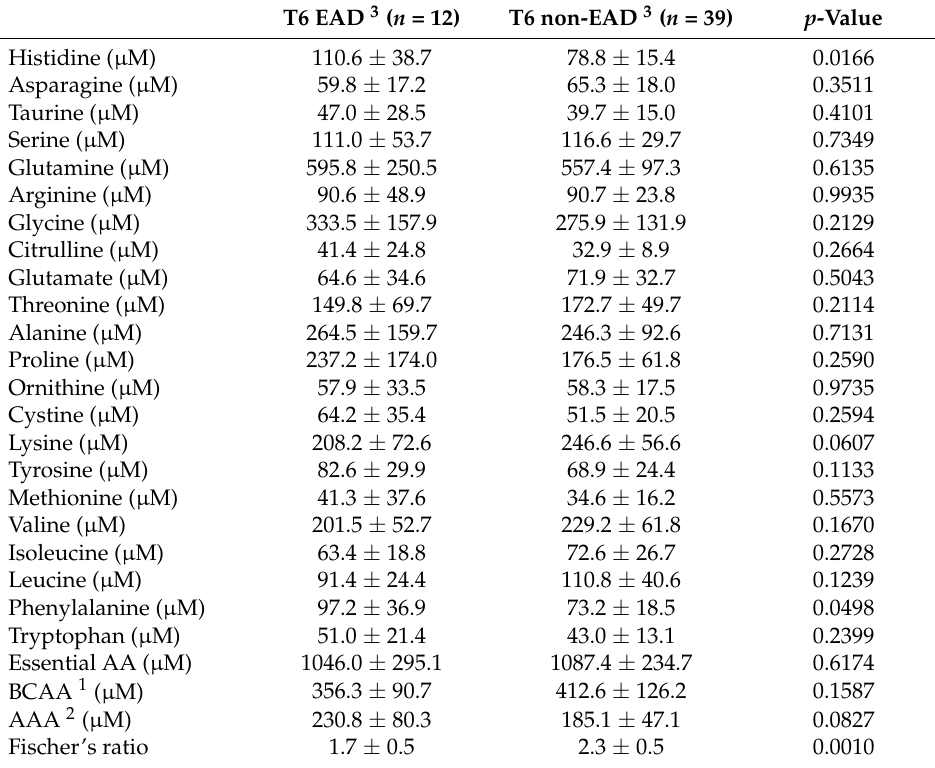
Table 3. Concentrations of amino acid of EAD in comparison to non-EAD recipients at T6 (postoperative day